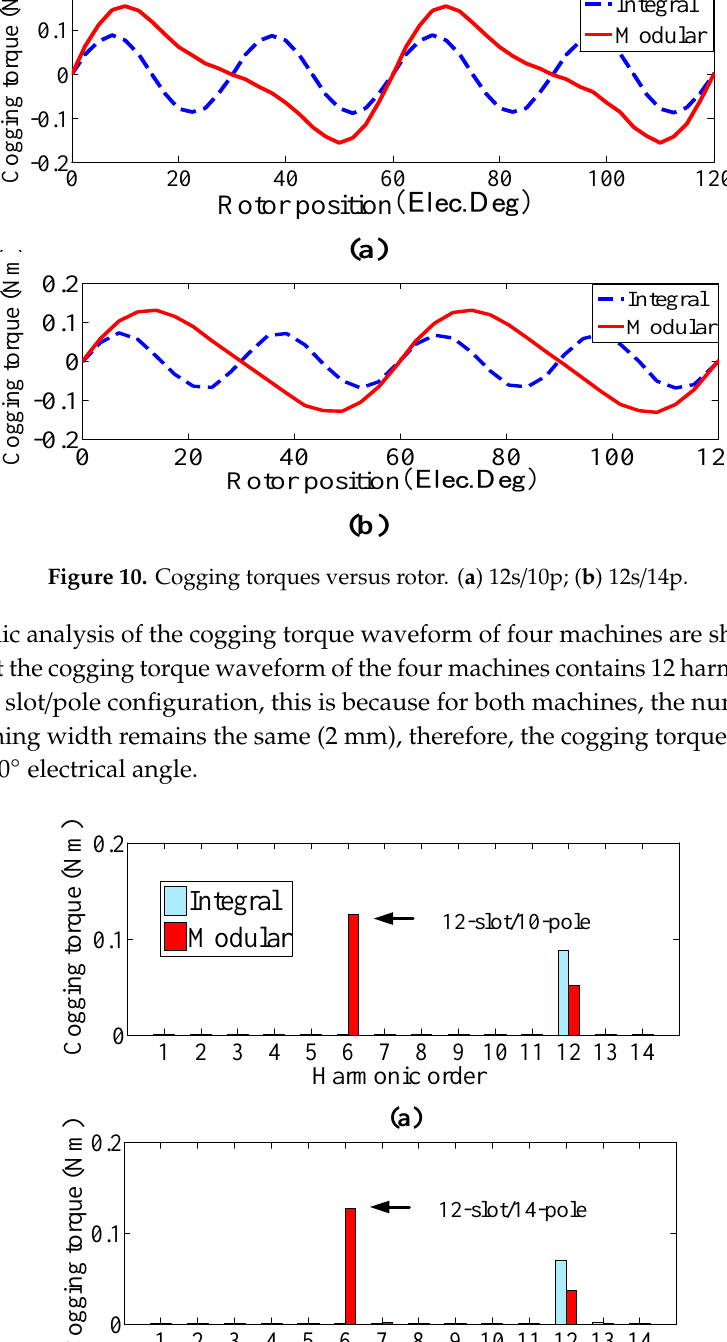
Figure 11. Cogging torques harmonics. ( a ) 12s/10p; ( b ) 12s/14p.